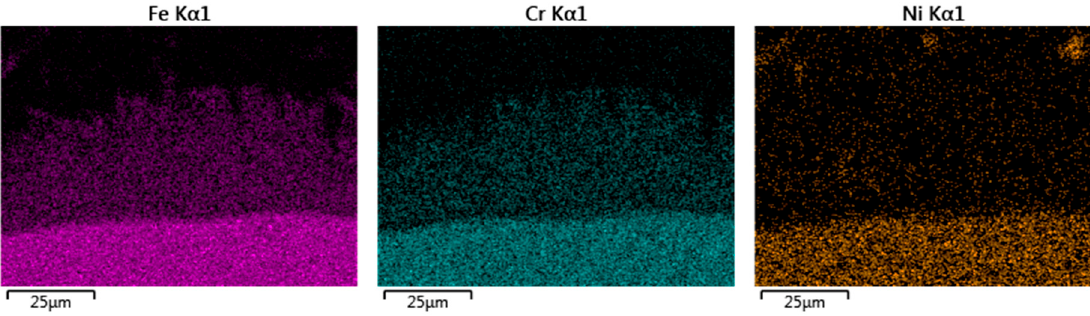
Figure 21. E 18 8 Mn B 2 2/680 ± 20 °C/300 min/AlSi9. EDX semi-quantitative microanalyses (mapping). Table 10. E 18 8 Mn B 2 2/680 ± 20° C/300 min/AlSi9. EDX semi-quantitative